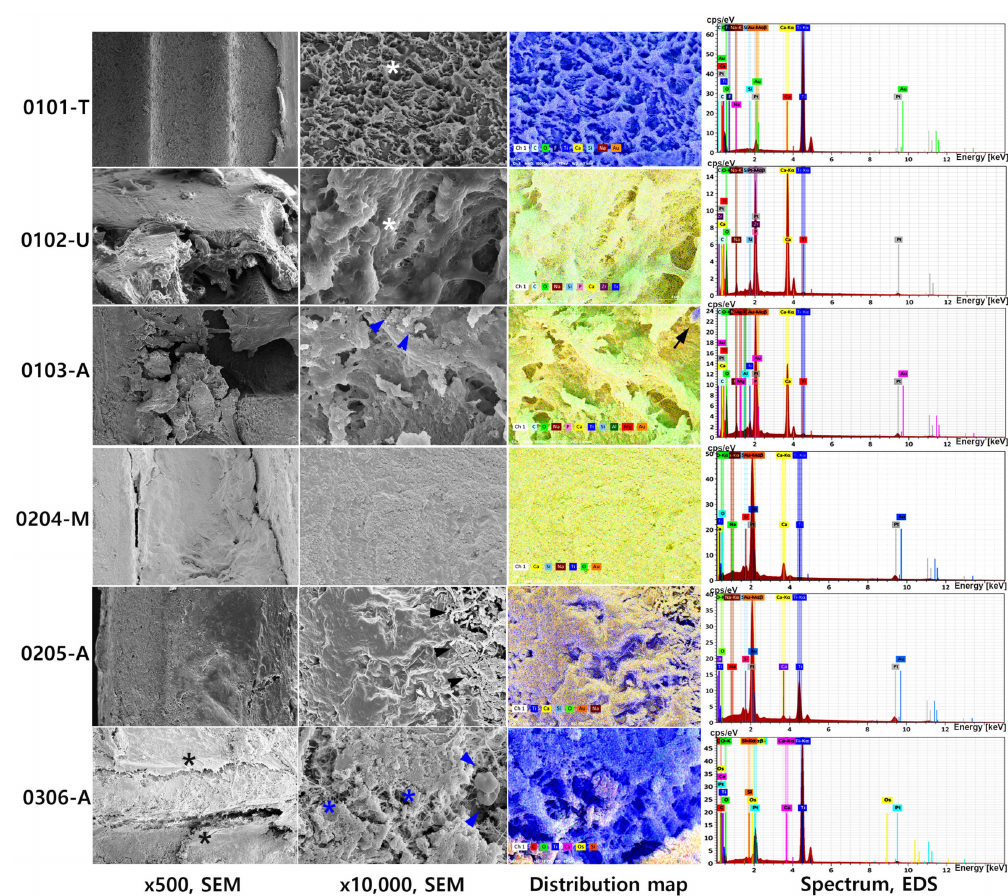
Figure 5. SEM micrograph at 500 × and 10,000 × magnification, EDS elemental distribution map and a spectrum of representative points pertaining to the three failed implants. In case 1, the SEM micrograph of the exposed implant surface revealed the pattern of sandblasting and acid etching surface (0101-T, white asterisk). Bone tissue attached at the implant upper part (0102-U, white asterisk) was found to have a more compact structure than bone in the apical region, per both SEM micrograph analysis and EDS composition results (0103-A, blue arrowhead). A Ti particle was also detected and is displayed on the distribution map (0103-A, distribution map, arrow). The Ca/P ratio of bone in 0102-U is higher than that in 0103-A (4.1 vs. 2.6). Noticeably, a significant level of zirconium (Zr) (9.19%) was detected in 0102-U, together with trace signals of Ti, Na, and Si. In case 2, The integrated bone on the implant surface showed a pattern of sclerosing bone with rare signs of bone lacunae (0204-M). In the apical region of the implant, massive infiltration of fungal hyphae was seen (0205-A, arrows). EDS analysis was performed at the implant surface and also revealed a significantly high percentage of Au (15.68%), along with two other major components, which were Ti and O. Si. In case 3, the implant surface was covered in organic membrane tissue, which can be observed on the low magnification (0306-A, black asterisks), blood cells (0306-A, blue arrowheads), and fibrin (0306-A, blue asterisks). Ti, O, and C were major compositions of this region, with a high percentage of Ti